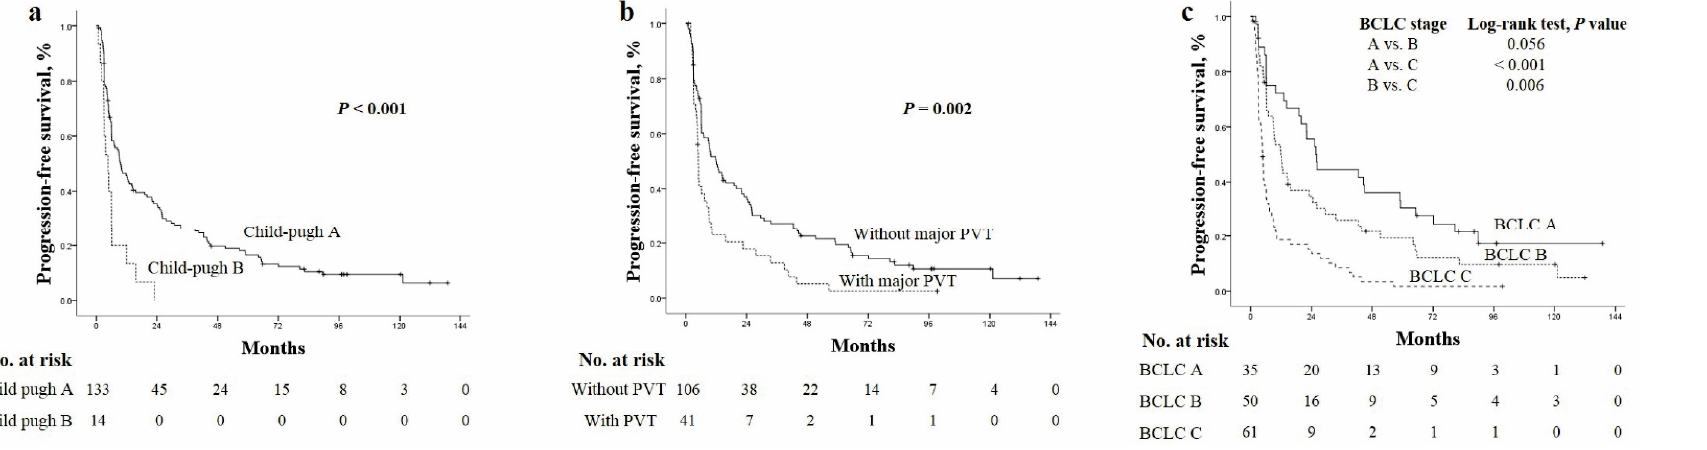
Figure 4. The Kaplan–Meier curves of overall survival according to ( a ) Child–Turcotte–Pugh score, ( b ) presence of PVT and ( c ) BCLC stages. BCLC, Barcelona Clinic Liver Cancer; HCC, hepatocellular carcinoma; PVT, portal vein thrombosis.